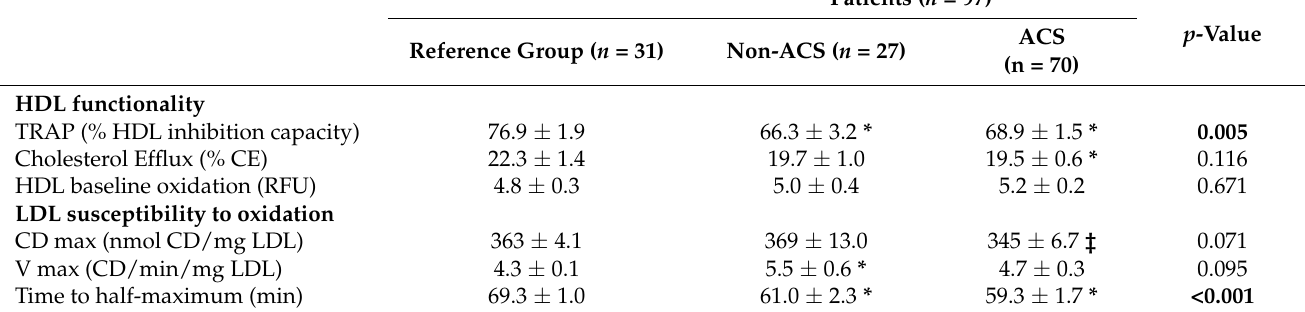
Table 3. Differences between the reference and non-ACS/ACS groups. Results are expressed as mean ± SEM. The ANOVA test was applied for multiple comparisons and the Bonferroni post hoc test was run for two group comparisons after ANOVA: * , significant changes versus the reference group; ‡ , significant changes between Non-ACS and ACS groups. Values of p < 0.05 are considered significant. Abbreviations: ACS = Acute Coronary Syndrome, TRAP = The Total-Radical-Trapping Antioxidative Potential, CD max = Maximum of Conjugated Dienes, V max = Maximum Velocity, BNP = B-Type Natriuretic Peptide, LVEF = Left Ventricular Ejection Fraction.